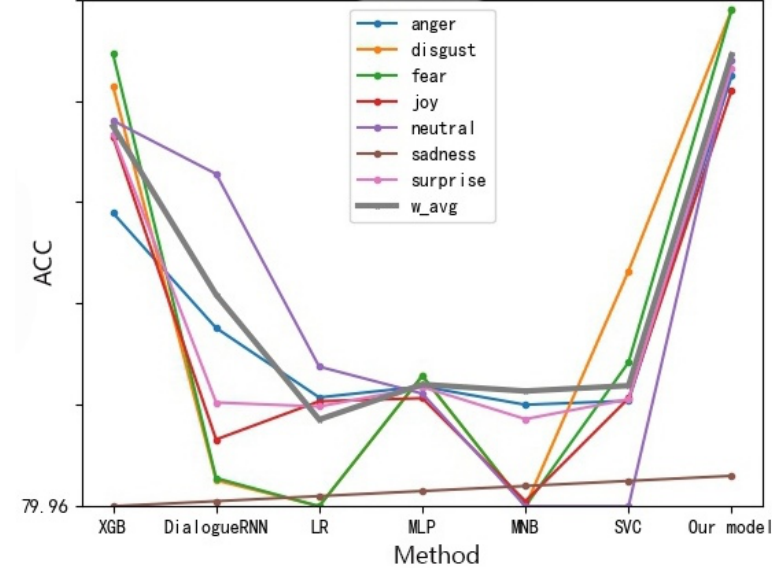
Figure 7. Fine-grained Emotion Accuracy Rate of Different Methods of MELD Data Set (speech).